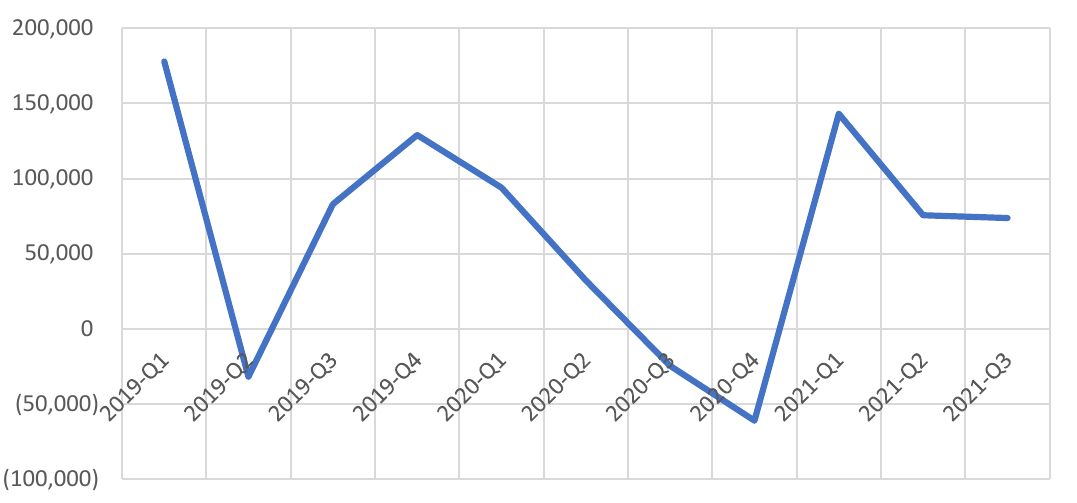
Figure 3. Outward FDI flows, EU, million USD, Q1 2019–Q3 2021. Source: OECD (2022), FDI flows (indicator). Doi:10.1787/99f6e393-en (accessed on 1 February 2022).